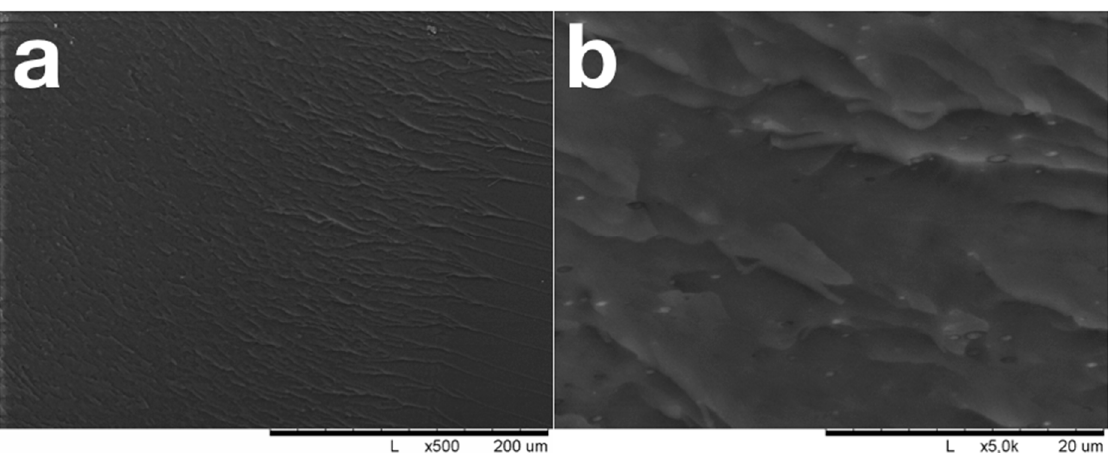
Figure 3. SEM images of carbonized pure NBR fracture surface.